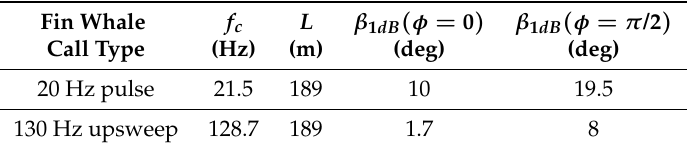
Table 1. POAWRS receiving array 1-dB angular width β 1 dB ( φ , f c ) at broadside ( φ = 0 ) and endfire ( φ = π /2 ) , given ULF aperture length L , as a function of center frequency f c for a given fin whale call type. The amplitude weighted average frequency values in Table 2 of [1] were used as the center frequency values. A Hanning spatial window is applied in the